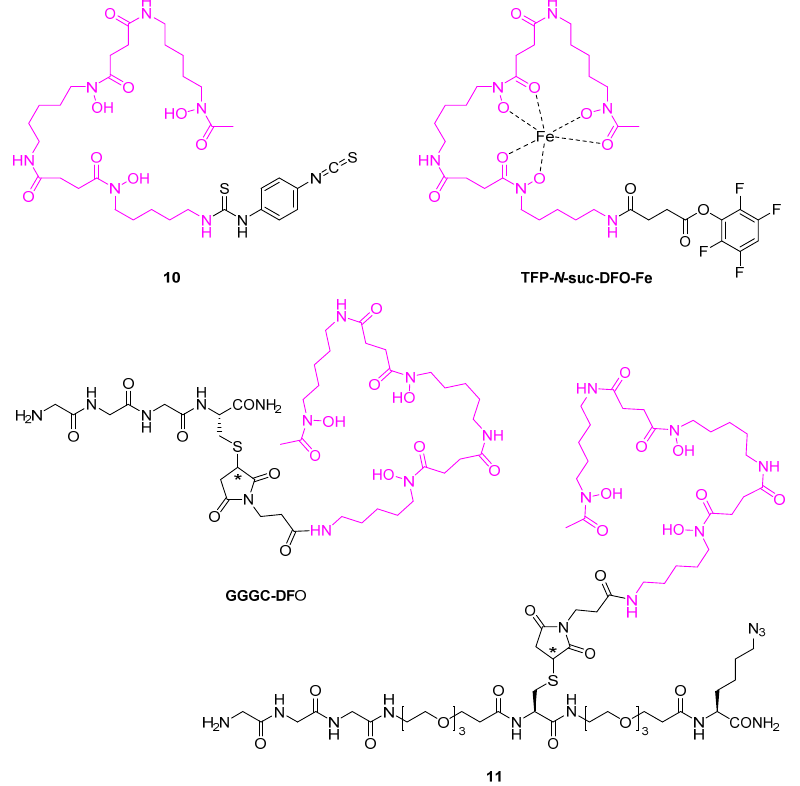
Figure 13. Desferrioxamine B (DFO)-based synthetic chelators used for radiometal labeling of nanobodies. DFO substructure is highlighted in pink.